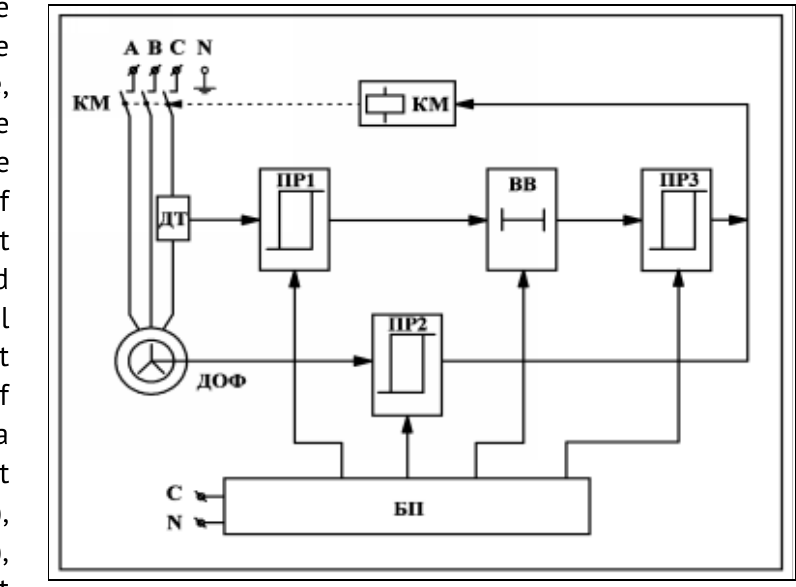
Figure 1 .The block scheme of the protection